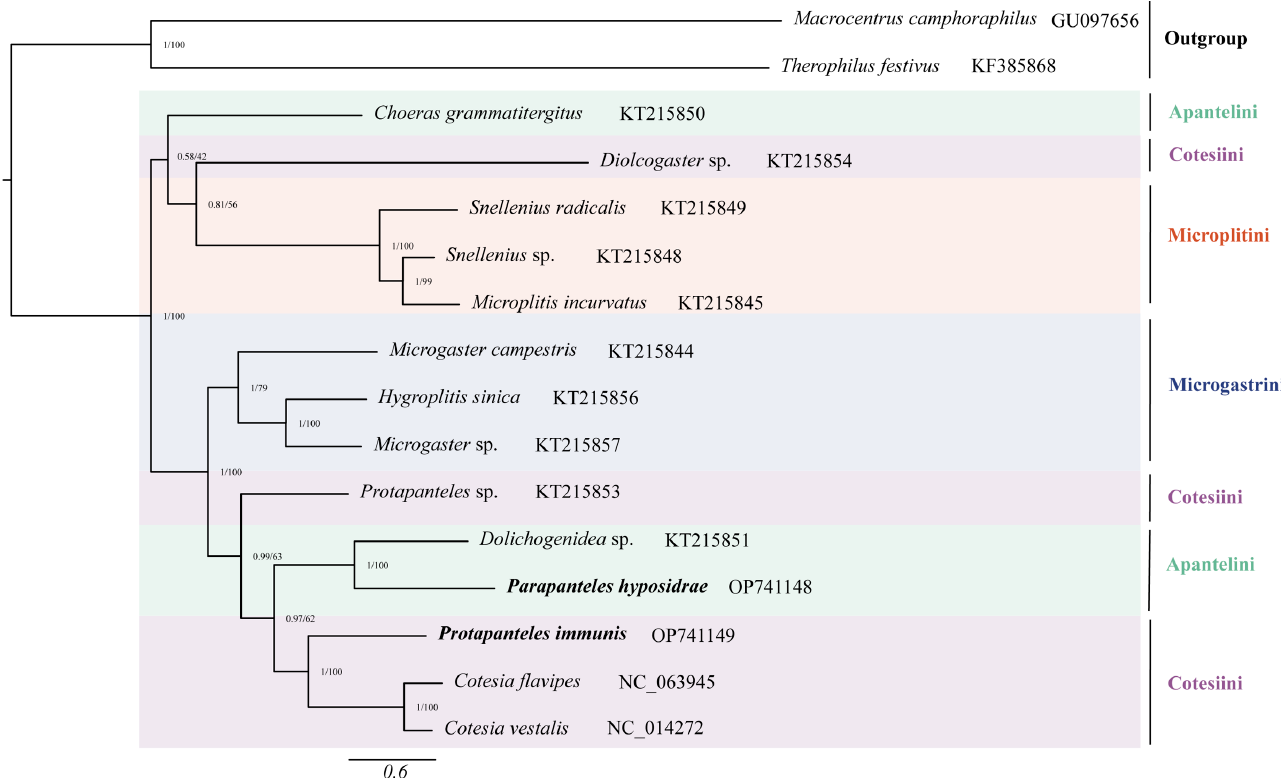
Figure 4. Phylogenetic analyses of Microgastrinae and two outgroups based on nucleotide datasets of 13 PCGs. Numbers separated by a slash on the node represent posterior probability (PP) (left) and bootstrap value (BV) (right). The graphic depicts the GenBank accession numbers for all species.